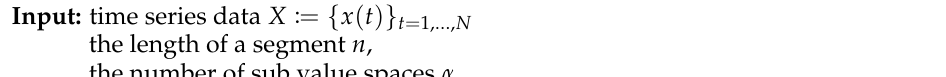
Algorithm 1 Transitional SAX. the length of a segment n , the number of sub value spaces